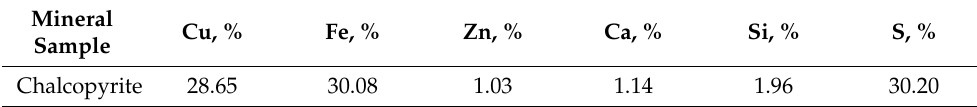
Table 3. X-ray fluorescence analysis for chalcopyrite ore.